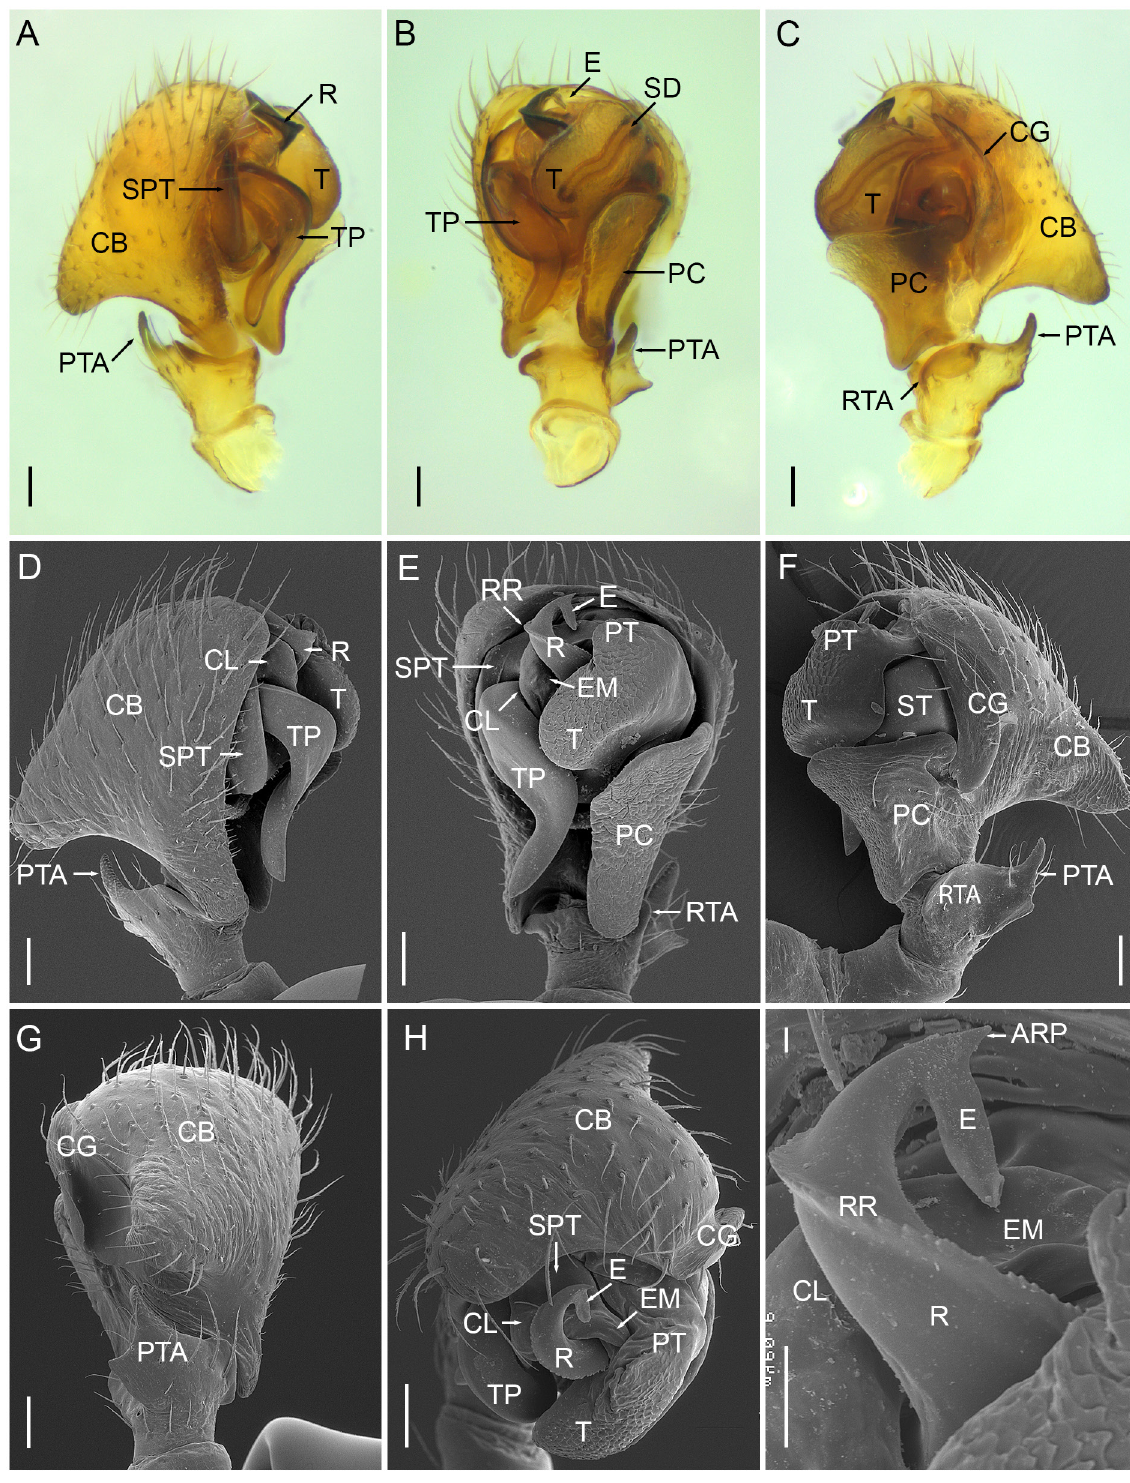
Fig. 2. Xim trenzado gen. et sp. nov., male left palpus. A–C . ECOTAAR-004974. D–E, G–I . ECOTAAR-004950. F . ECOTAAR-004952. A, D . Mesal view. B, E . Ventral view. C, F . Ectal view. G . Dorsal view. H . Apical view. I . Detail of E showing radix and embolus. Scale bars: A–E = 50 μm; F = 20